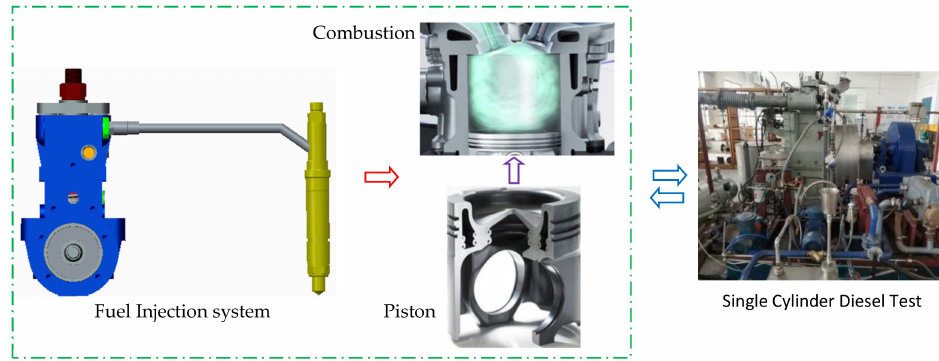
Figure 1. The overall schematic of research plan of fuel injection on combustion.